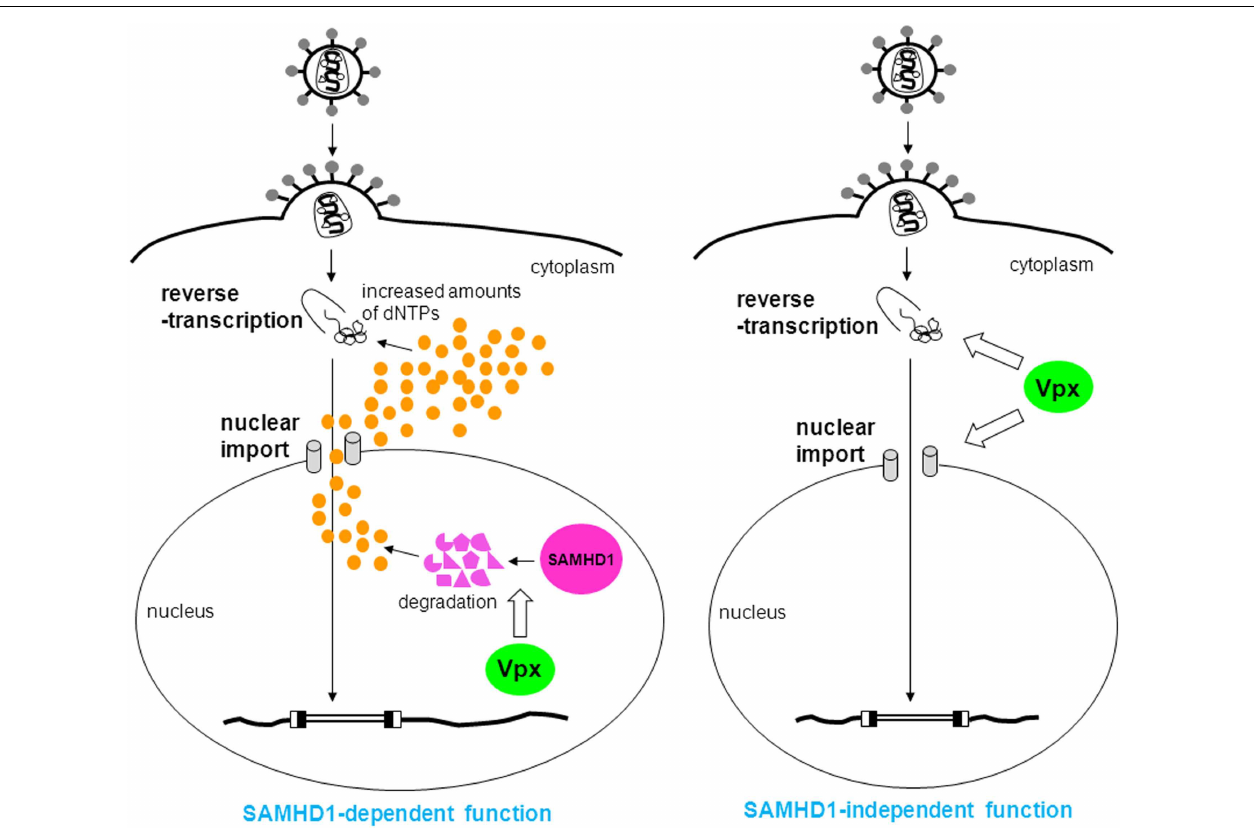
FIGURE 2 | SAMHD1-dependent and -independent functions ofVpx. In the former function,Vpx degrades SAMHD1 to increase amounts of dNTPs (orange circles), thus, reverse transcription proceeds (left). In the latter function,Vpx enhances reverse transcription and nuclear import by an unknown mechanism (right).